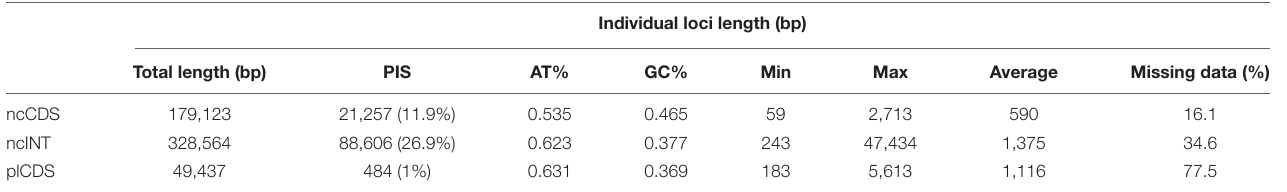
TABLE 2 | Length of trimmed aligned contigs and parsimony informative sites (PIS) for the three datasets used in downstream analyses. Individual loci length